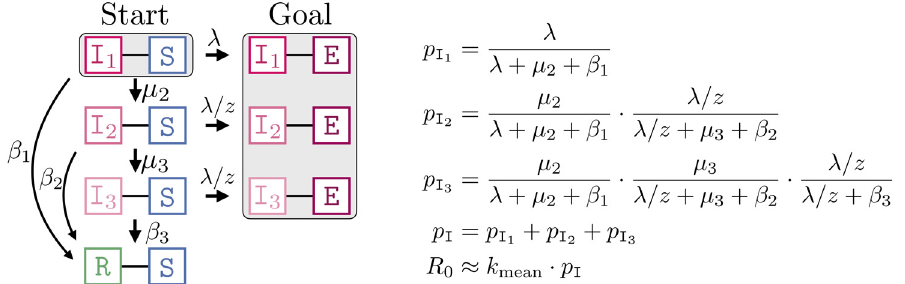
Fig 3. Computation of R 0 for fixed λ . Right : The probability that an I 1 − S edge transmits the infection, p I , is the sum of